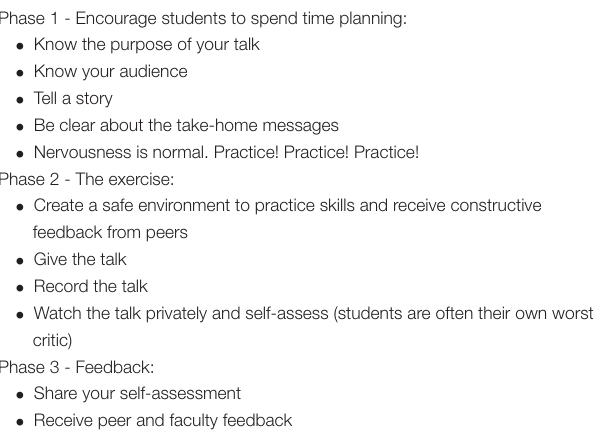
TABLE 4 | Key points of the presentation